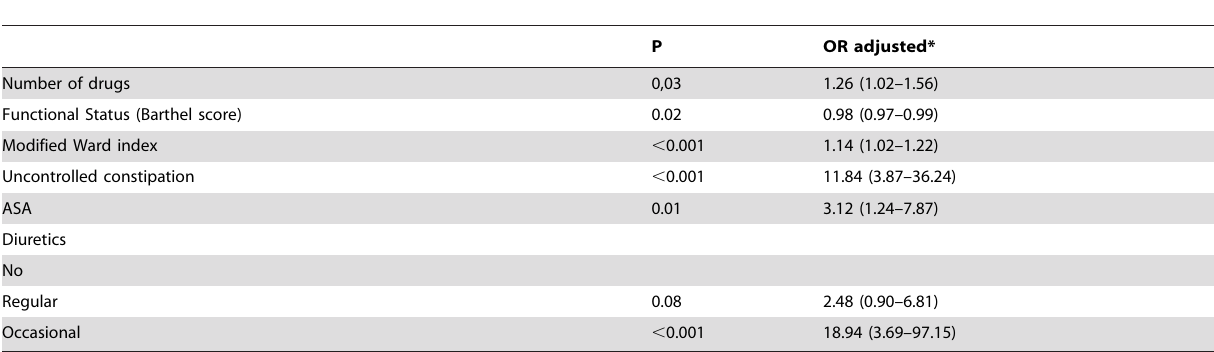
Table 6. Multivariate Model: factors associated with fecal impaction in rectal